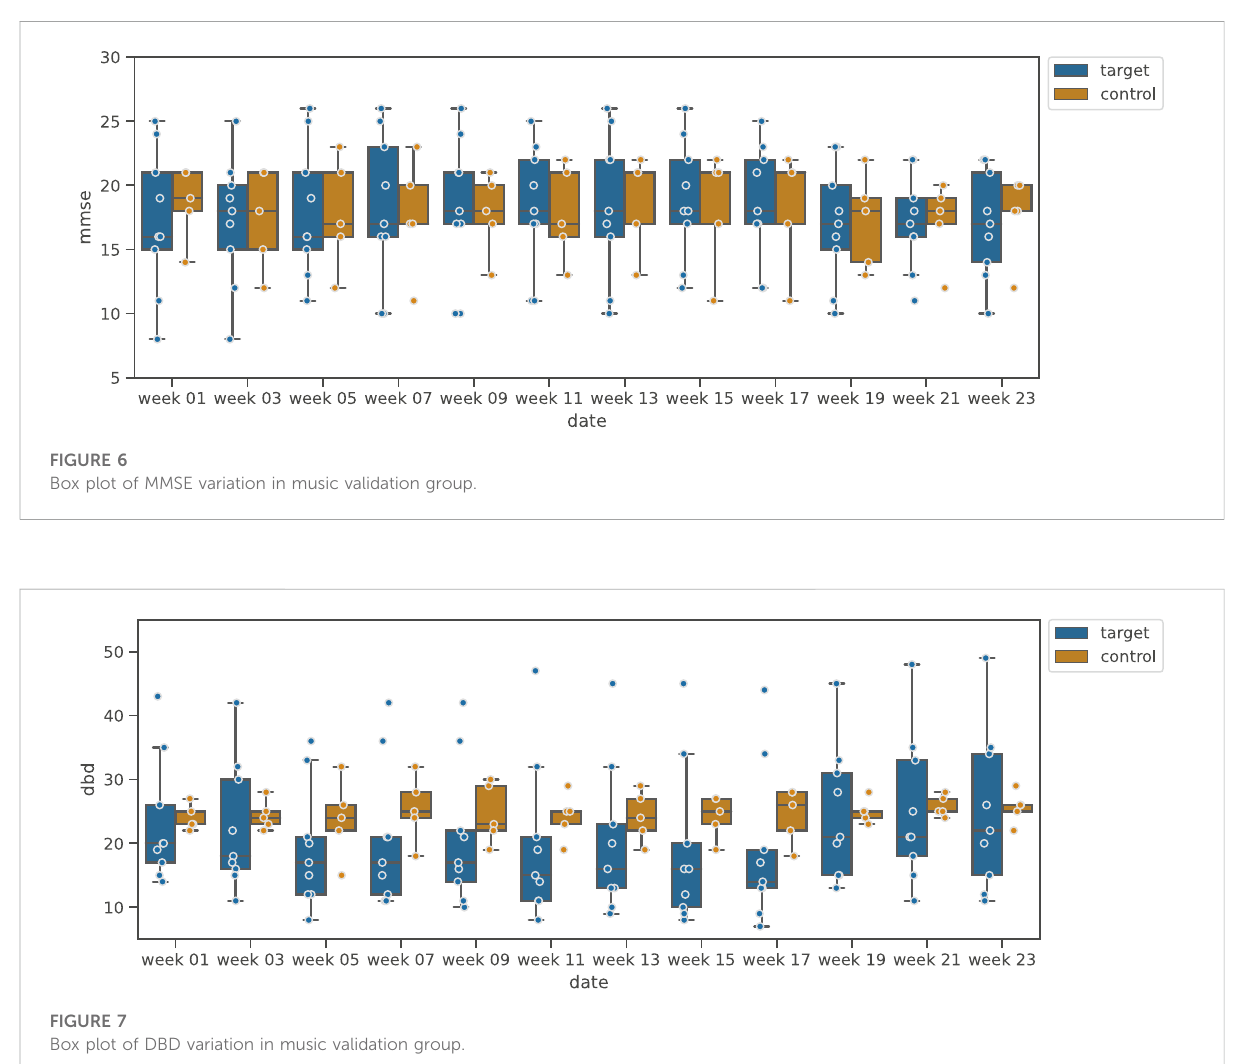
FIGURE 7 Box plot of DBD variation in music validation